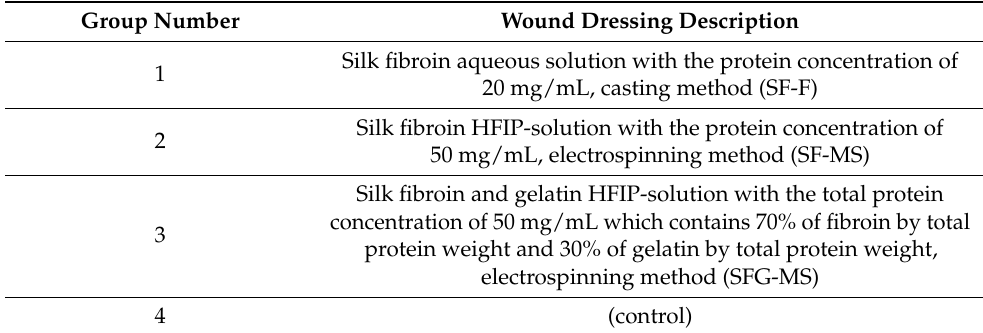
protein weight and 30% of gelatin by total protein